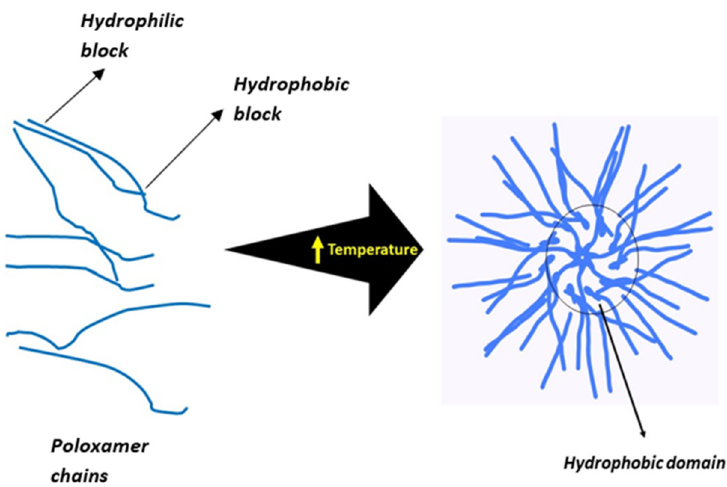
Figure 3. Mechanism of a temperature-sensitive system [69]